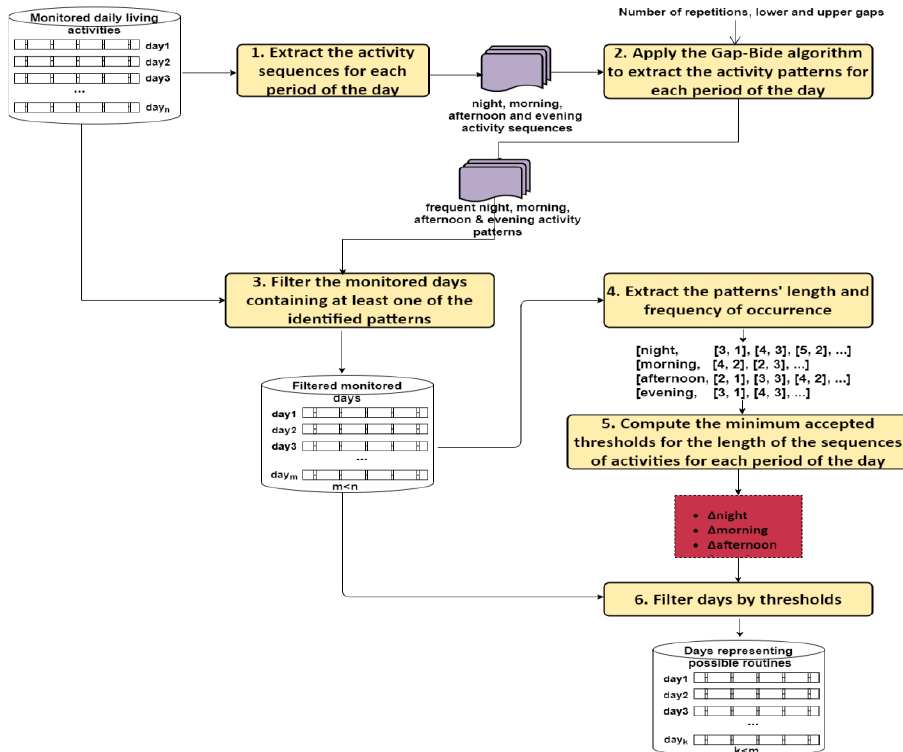
Figure 2. Frequent sequence identification using Gap-BIDE algorithm. Six steps are defined for extracting days that could represent routines or patterns. Table 3. Day division in